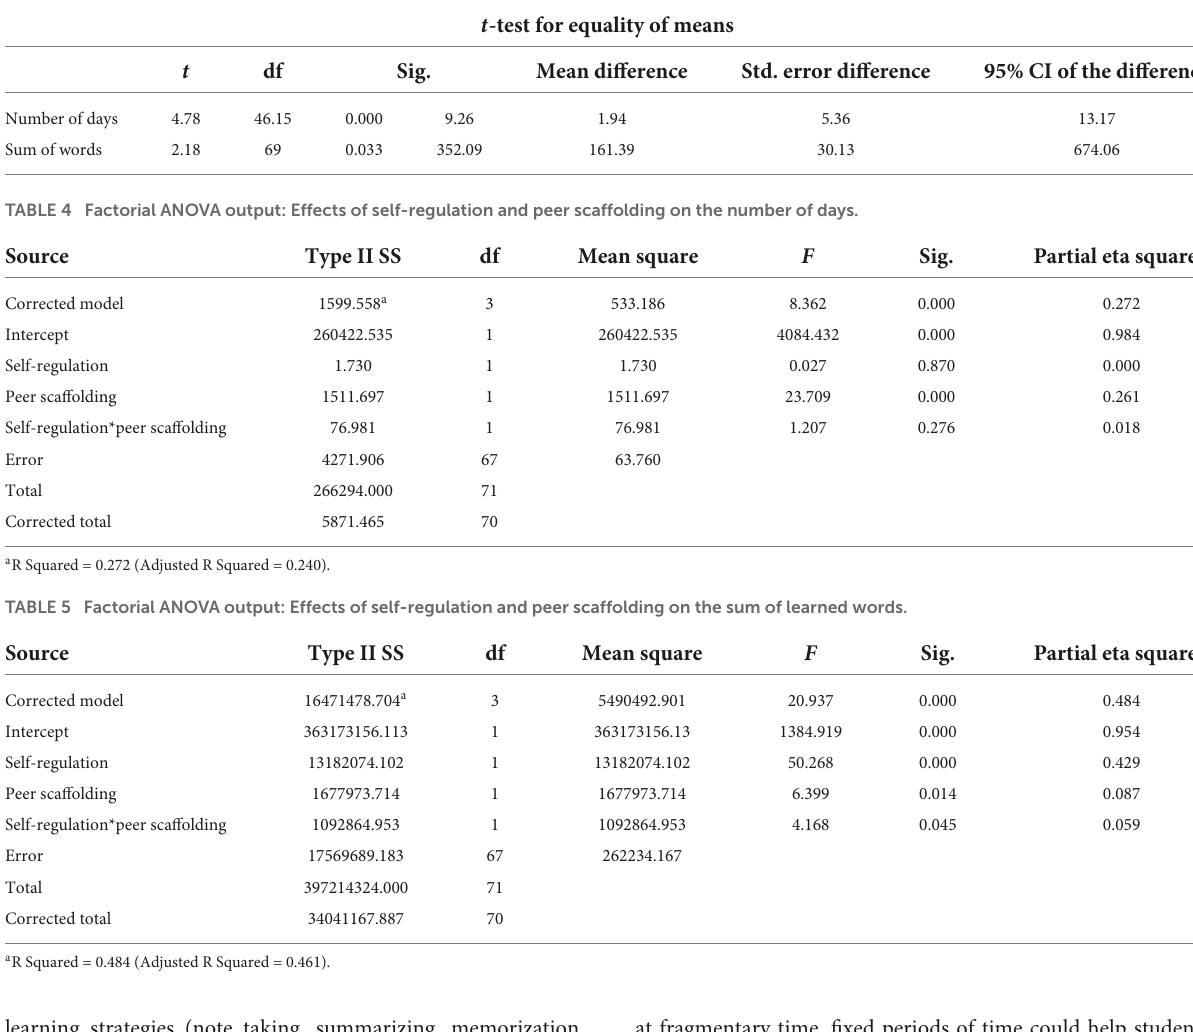
TABLE 3 Output from the independent samples t -test.